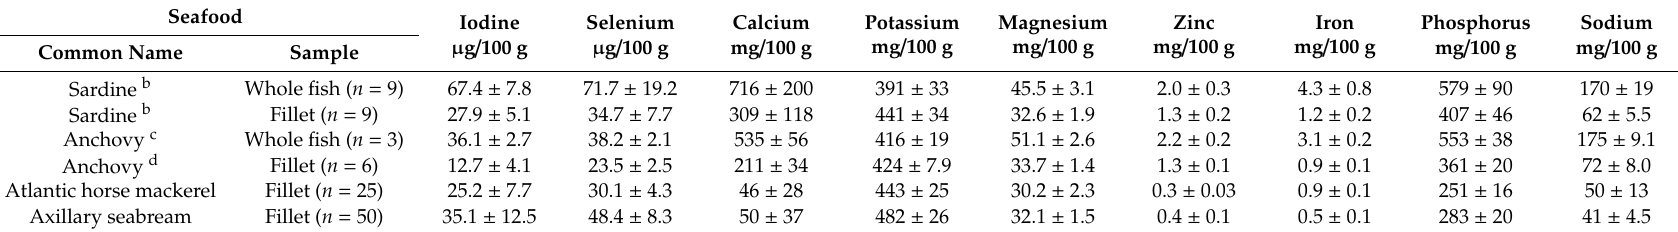
Table 8. Analytical values of selected minerals in in di ff erent species of fish sampled on the EAF Dr. Fridtjof Nansen cruise from Tangier to Cap Bojador in May 2017 (mean ± SD) a